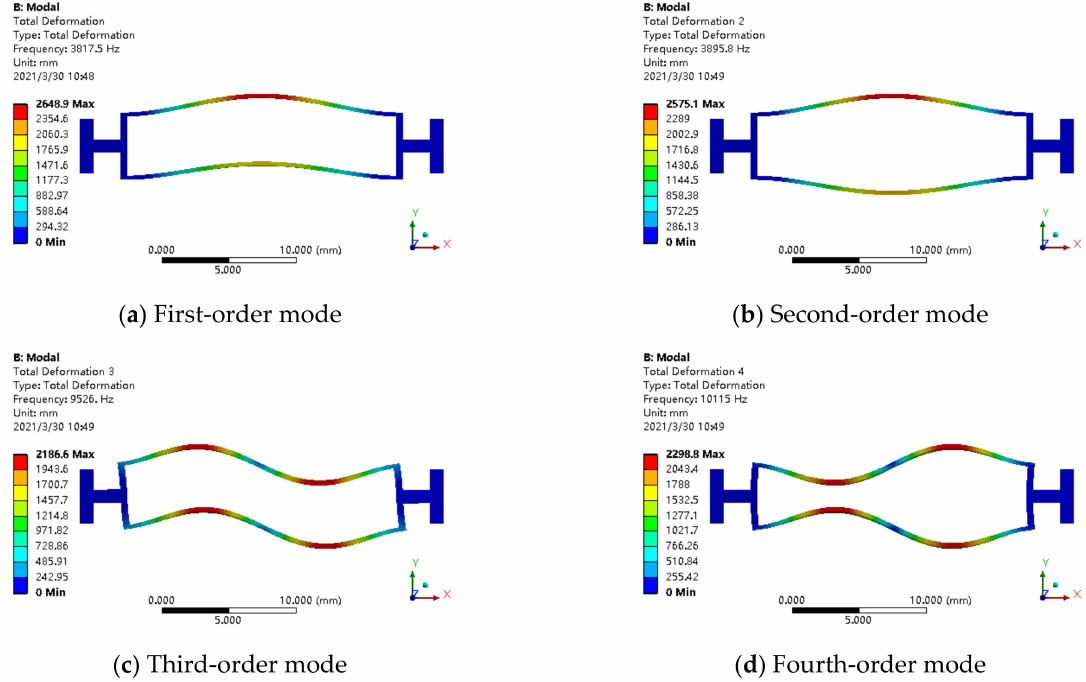
Figure 13. Beam root 2: ( a ) first-order mode; ( b ) second-order mode; ( c ) third-order mode; ( d ) fourth-order